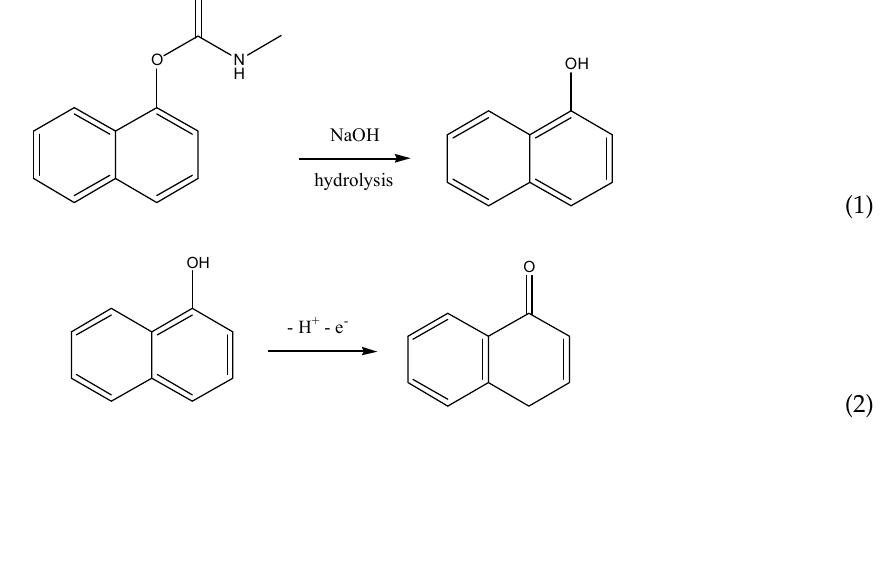
( B ) Figure 1. ( A ) Cyclic voltammetry (CV) curves of 25 μ M carbaryl (CBL) in 0.1 M phosphate-buffered saline (PBS, pH 7.0) before (a) and after (b) hydrolysis. ( B ) Square wave voltammetry (SWV) (a), differential pulse voltammetry (DPV) (b), linear sweep voltammetry (LSV) (c), and CV (d) curves of 25 μ M CBL in 0.1 M PBS (pH 7.0) after hydrolysis. The reference signal is an essential element in RECS [39,40]. Hence, several common probes with electrochemical activity have been investigated for the fabrication of CBL-RECSs. The electrochemical behaviour of the four probes is shown in Figure 2A. It can be seen that the peak potential of Fc is too near with the derivation product of CBL (curve b) and there was also a weak peak of MB next to a-CBL (curve c), which means Fc and MB were not able to separate well with a-CBL. At the same time, the peaks of Th (curve d) and NB (curve e) were well defined so that they are more suitable to be reference probes for electrochemical determination of CBL in this regard. In addition, compared with a-CBL without any probes (curve a), the introduction of Th obviously reduced the peak current of a-CBL, making it unsuitable for CBL determination. Till now, NB seemed to be the most probable reference probe for CBL. In order to verify the conjecture, stability experiments were also carried out. The RSD of peak current ratio between a-CBL and NB was calculated to be only 2.5%, when the mixture was tested for 5 times under the same conditions every ten minutes. Besides, the adding sequence of reference probe and alkali were also investigated. As